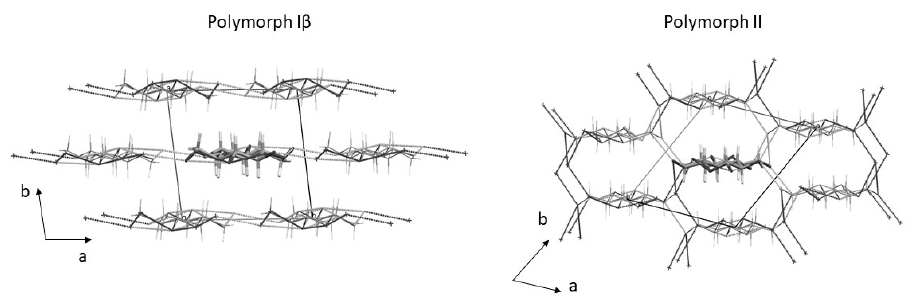
Figure 3. Projection along the c axis for both polymorphic forms observed in the CNC analyzed.